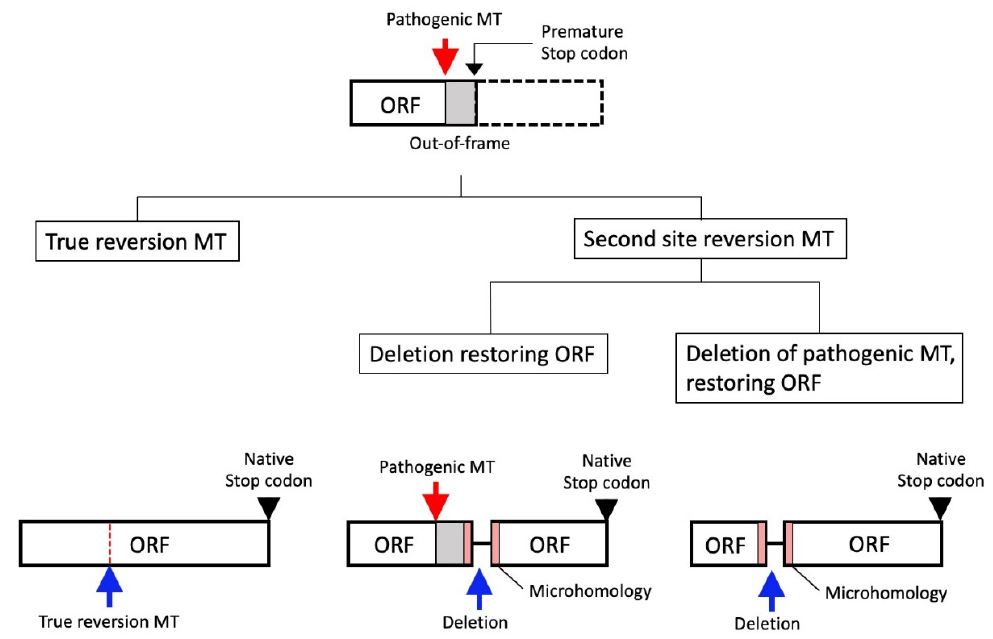
Figure 5. Representative types of reversion mutation. Architecture of the homologous recombination (HR) gene is shown. The HR gene with a pathogenic mutation (MT) and a resultant premature stop codon due to out of frame sequences are illustrated in the upper panel. The normal function of the gene is lost as a result of the MT and resultant premature stop codon. As shown in the lower panel, true reversion MT completely restores the pathogenic MT and open reading frame (ORF), while second site deletion, either encompassing or not encompassing the pathogenic MT, mostly being flanked by short regions of DNA sequence microhomology, generates an alternative ORF with a naive stop codon, leading to a restoration of gene function.